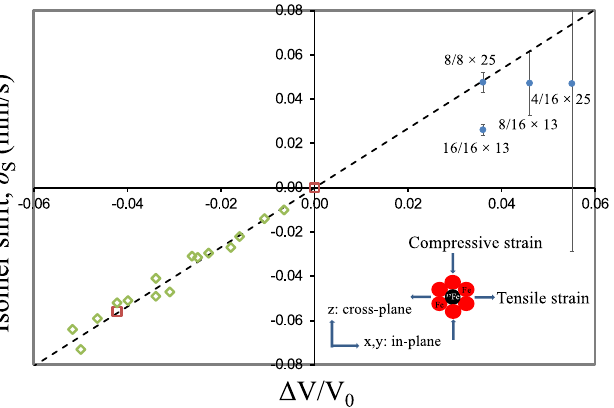
Figure 8. The influence of strain on the isomer shift ( δ S ) of the Fe − layer. Blue dots represent the isomer shifts of the Fe Fe component from the central Fe − layers ( δ S = δ Fe . centre ) in the superlattice sample as indicated, where the neighbour effect is negligible, only the strain effect is valid. The related error bars are added to each data series. The literature data obtained from the compressed Fe − foils are plotted for comparison. ∆ V / V 0 stands for the volume change of the Fe − lattice layer. The dashed line is defined by ∆ δ S / ∆ ( ∆ V / V 0 ) = 1.34 mm/s adapted with permission from [36]. Red squares represent the data adapted with permission from [36] and green diamonds the data adapted with permission from [35] using the ( ∆ V / V 0 ) / ∆ P = 5.95 × 10 − 4 kbar − 1 conversion adapted with permission from [36]. Copyrighted by the American Physical Society. Negative (positive) sign of ∆ V / V − lattice 0 indicates a compression (an expansion) of the Fe